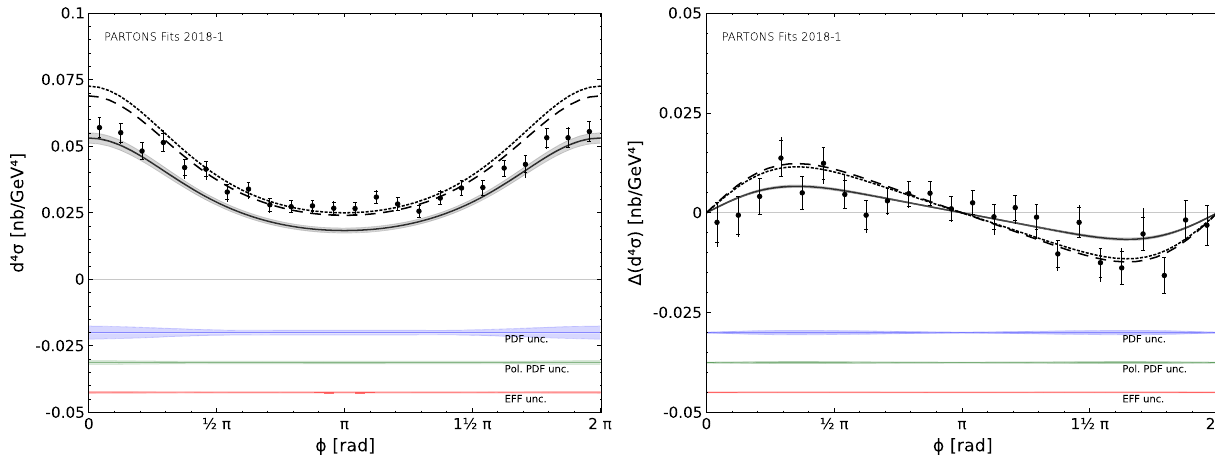
Fig. 7 Comparison between the results of this analysis, some selected GPD models and experimental data published by Hall A in Ref. [117] for d 4 σ − (left) and Δ d 4 σ − (right) at x Bj = 0 . 392, t = − 0 . 233 GeV 2 and Q 2 = 2 . 054 GeV 2 . For further description see Fig. UU LU